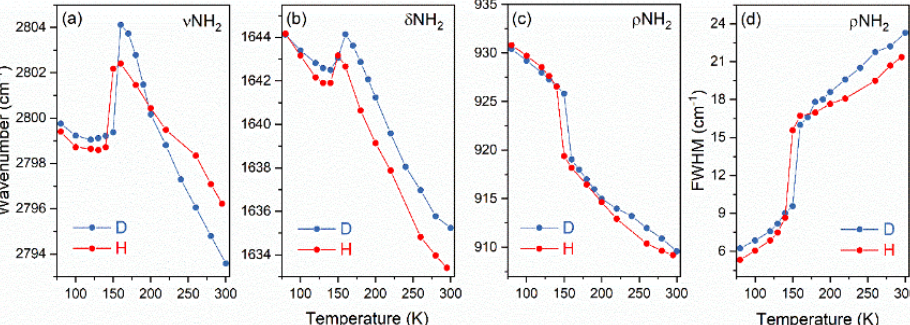
Figure 5. A comparison of the temperature dependencies of IR bands, corresponding to ν NH 2 ( a ), δ NH 2 ( b ), and ρ NH 2 ( c , d ) for DMAZnD (D, blue) and DMAZnF (H, red) [35]; the lines are guides for eyes, fwhm, full − width at half maximum.